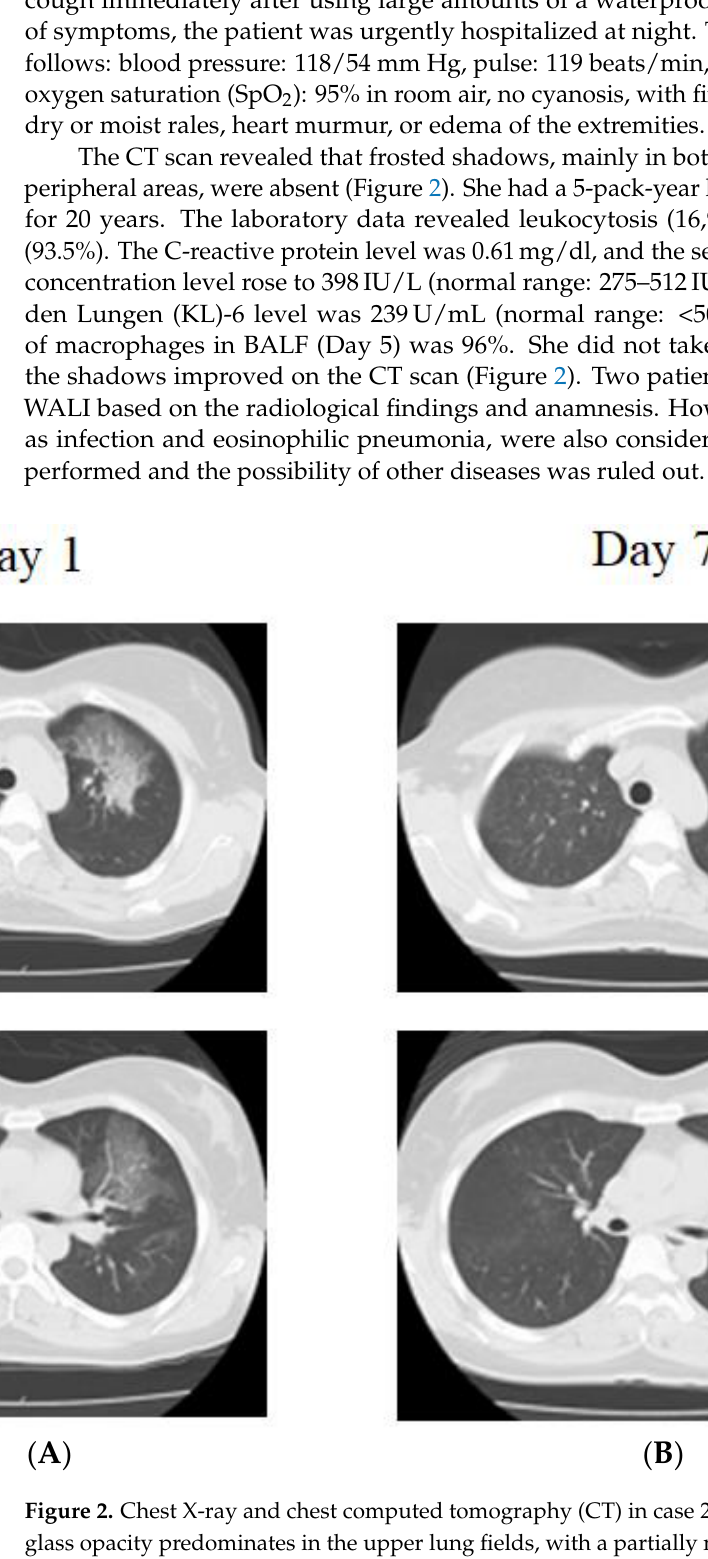
3 of 10 Figure 1. Chest X-ray and chest computed tomography (CT) in case 1. Bilateral diffuse, ground-glass opacity can be observed, but no pleural nadir shadow. A mosaic pattern can be observed in some areas (Day 14). There is a trend toward shadow reduction in both the upper and lower lung fields,